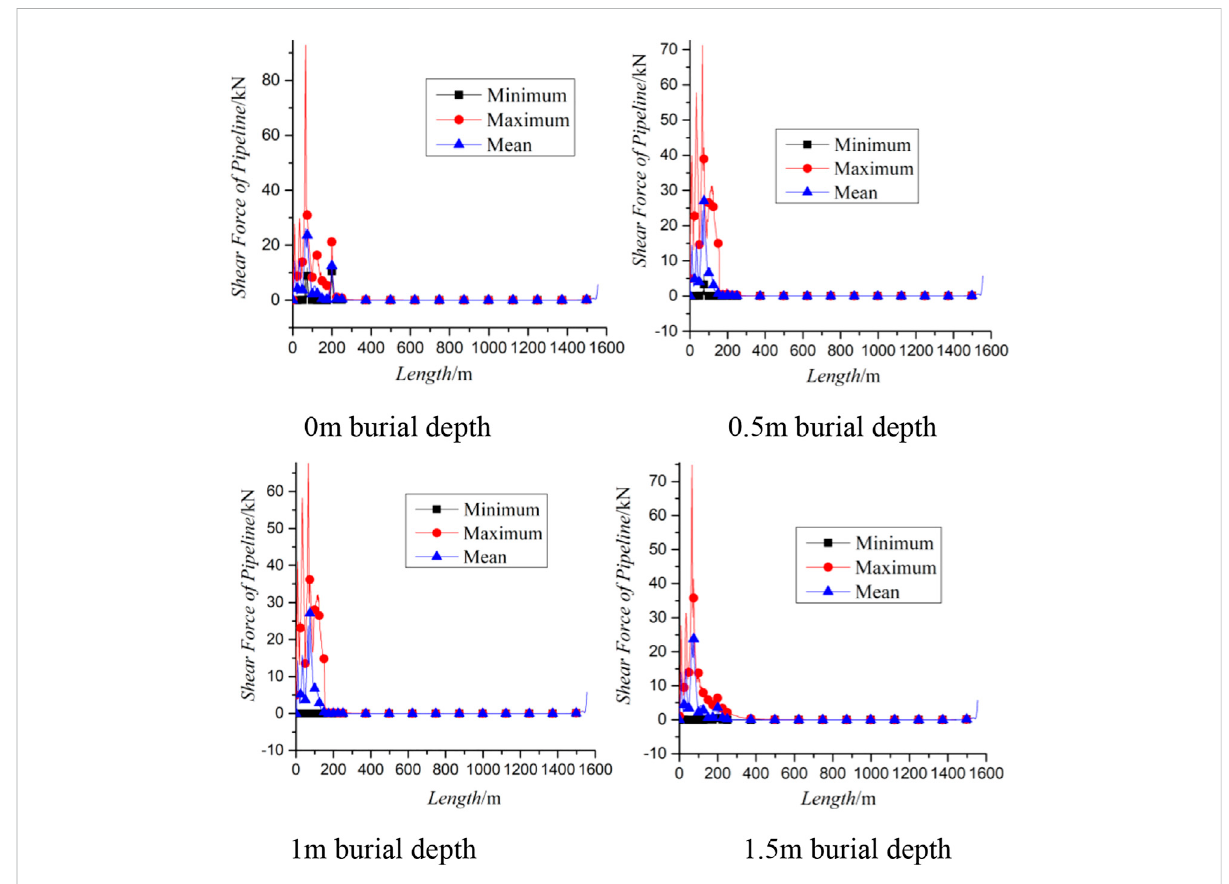
FIGURE 8 Shear force of the pipeline in the length direction with different burial